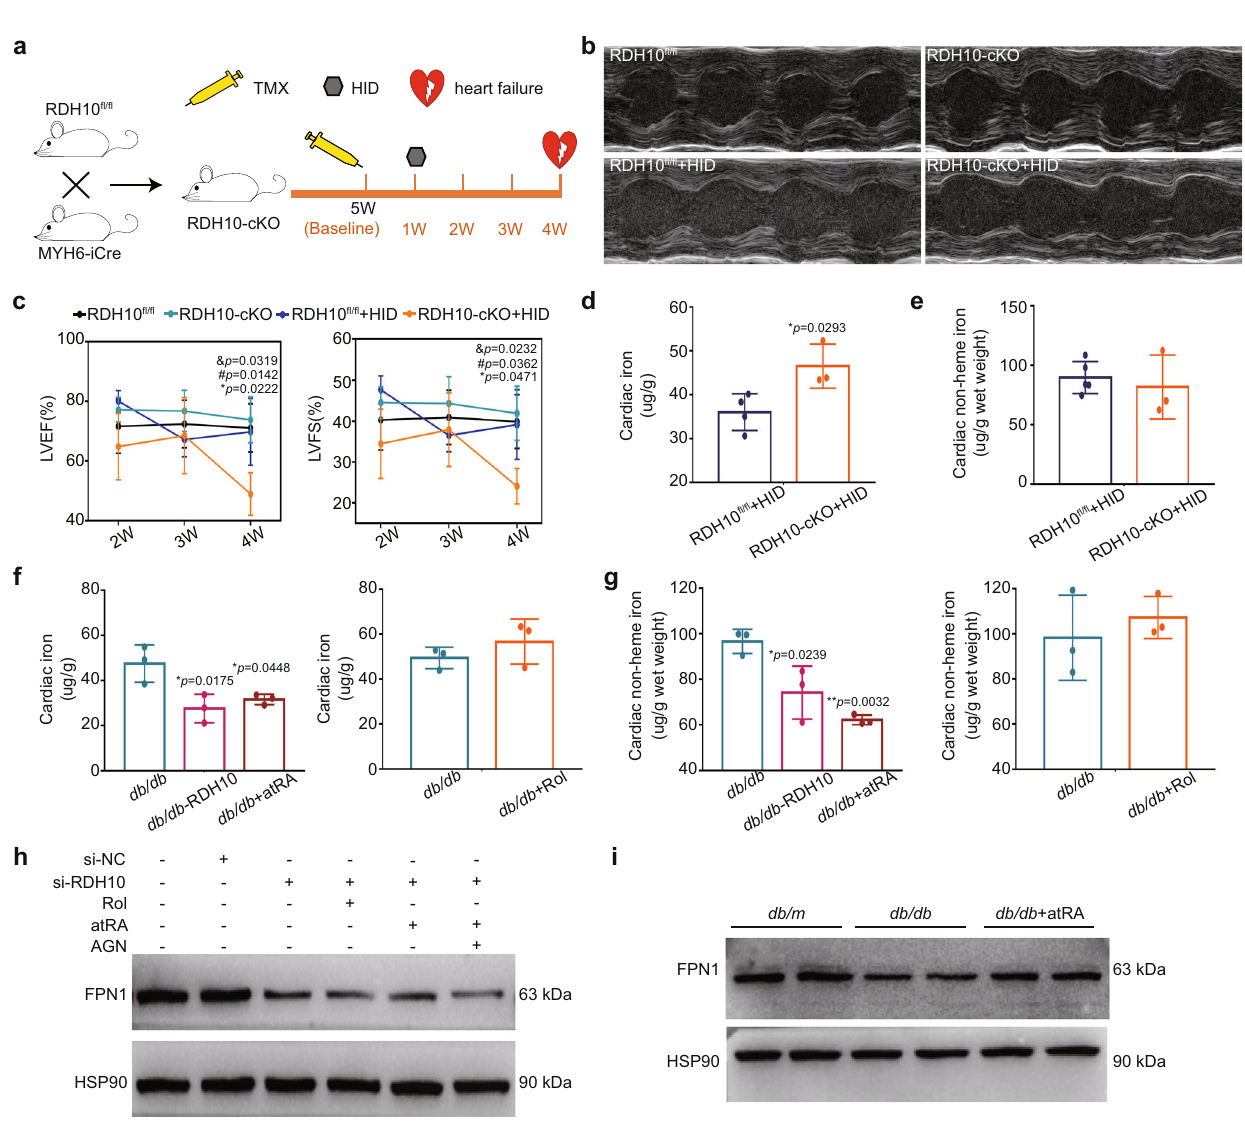
Fig. 8 | RDH10 reduction-induced retinol metabolism disorder promoted iron accumulation via atRA de fi ciency in the heart in T2DM ( n means biologically independent animals). a Schematic diagram of high iron diet (HID) treatment in RDH10-cKO mice. b Echocardiography. c LVEF and LVFS, n (2w)=3 (RDH10 fl / fl ), 4 (RDH10-cKO), 3 (RDH10 fl / fl +HID) and 3 (RDH10-cKO+HID); n (3w)=3 (RDH10 fl / fl ), 3 (RDH10-cKO), 4 (RDH10 fl / fl +HID) and 3 (RDH10-cKO+HID); n (4w)=5 (RDH10 fl / fl ), 4 (RDH10-cKO), 5 (RDH10 fl / fl +HID) and 3 (RDH10-cKO+HID); * vs RDH10 fl / fl ; # vs RDH10-cKO; & vs RDH10 fl / fl +HID. d Cardiac iron levels, n =4 (RDH10 fl / fl ) and 3 (RDH10-cKO),* vs RDH10 fl / fl +HID. e Cardiacnon-hemeironlevels, n =55(RDH10 fl / fl )